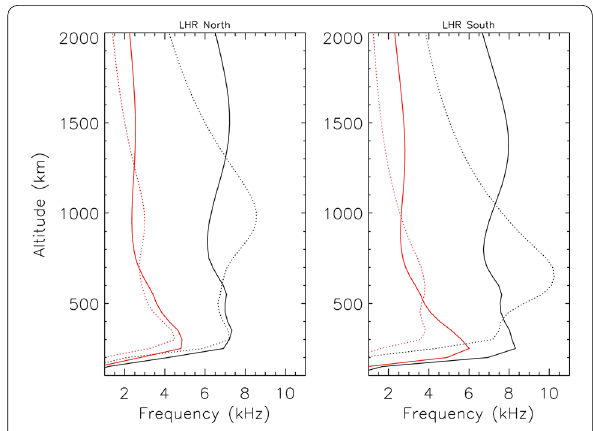
Fig. 30 LHR frequency profiles above HAARP (left panel) and its magnetically conjugate point (right panel) during day time (full lines) and nighttime (dotted lines). The red lines represent the LHR frequency profiles when the electron density given by the IRI2016 model is divided by 10 (see